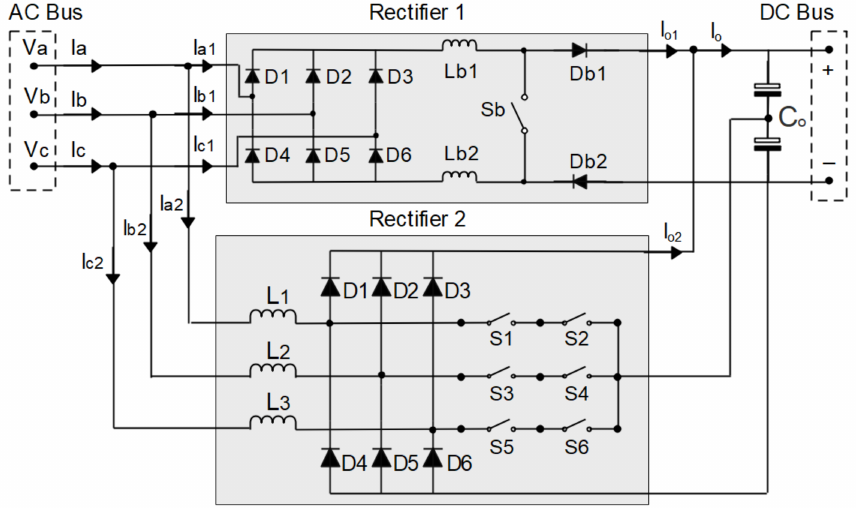
Figure 24. Configuration of the electrical circuit of the